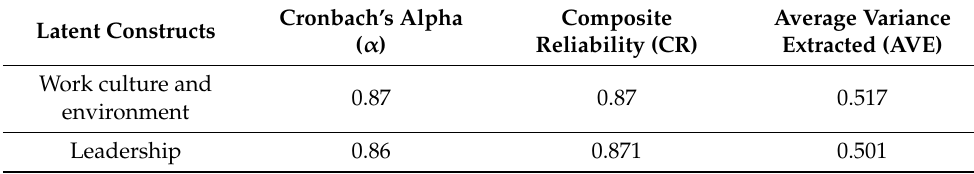
Table 4. Construct reliability and